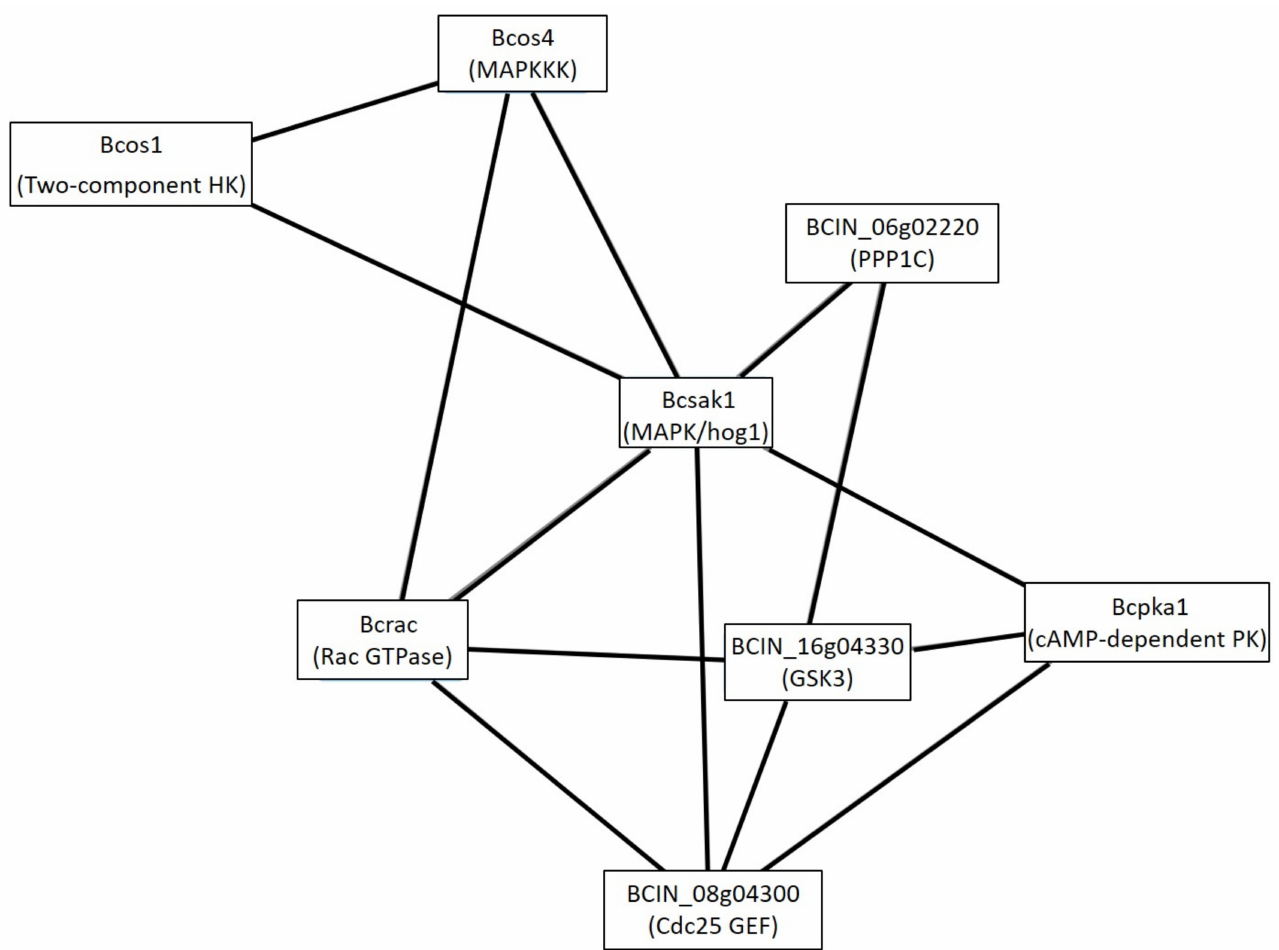
Figure 4. Cluster 15: signaling cluster under the GLU condition. Clusters were obtained analyzing STRING networks of protein exclusively identified or overexpressed in B. cinerea proteomes (membranome, phosphoproteome, phosphomembra- nome, and secretome) under GLU with